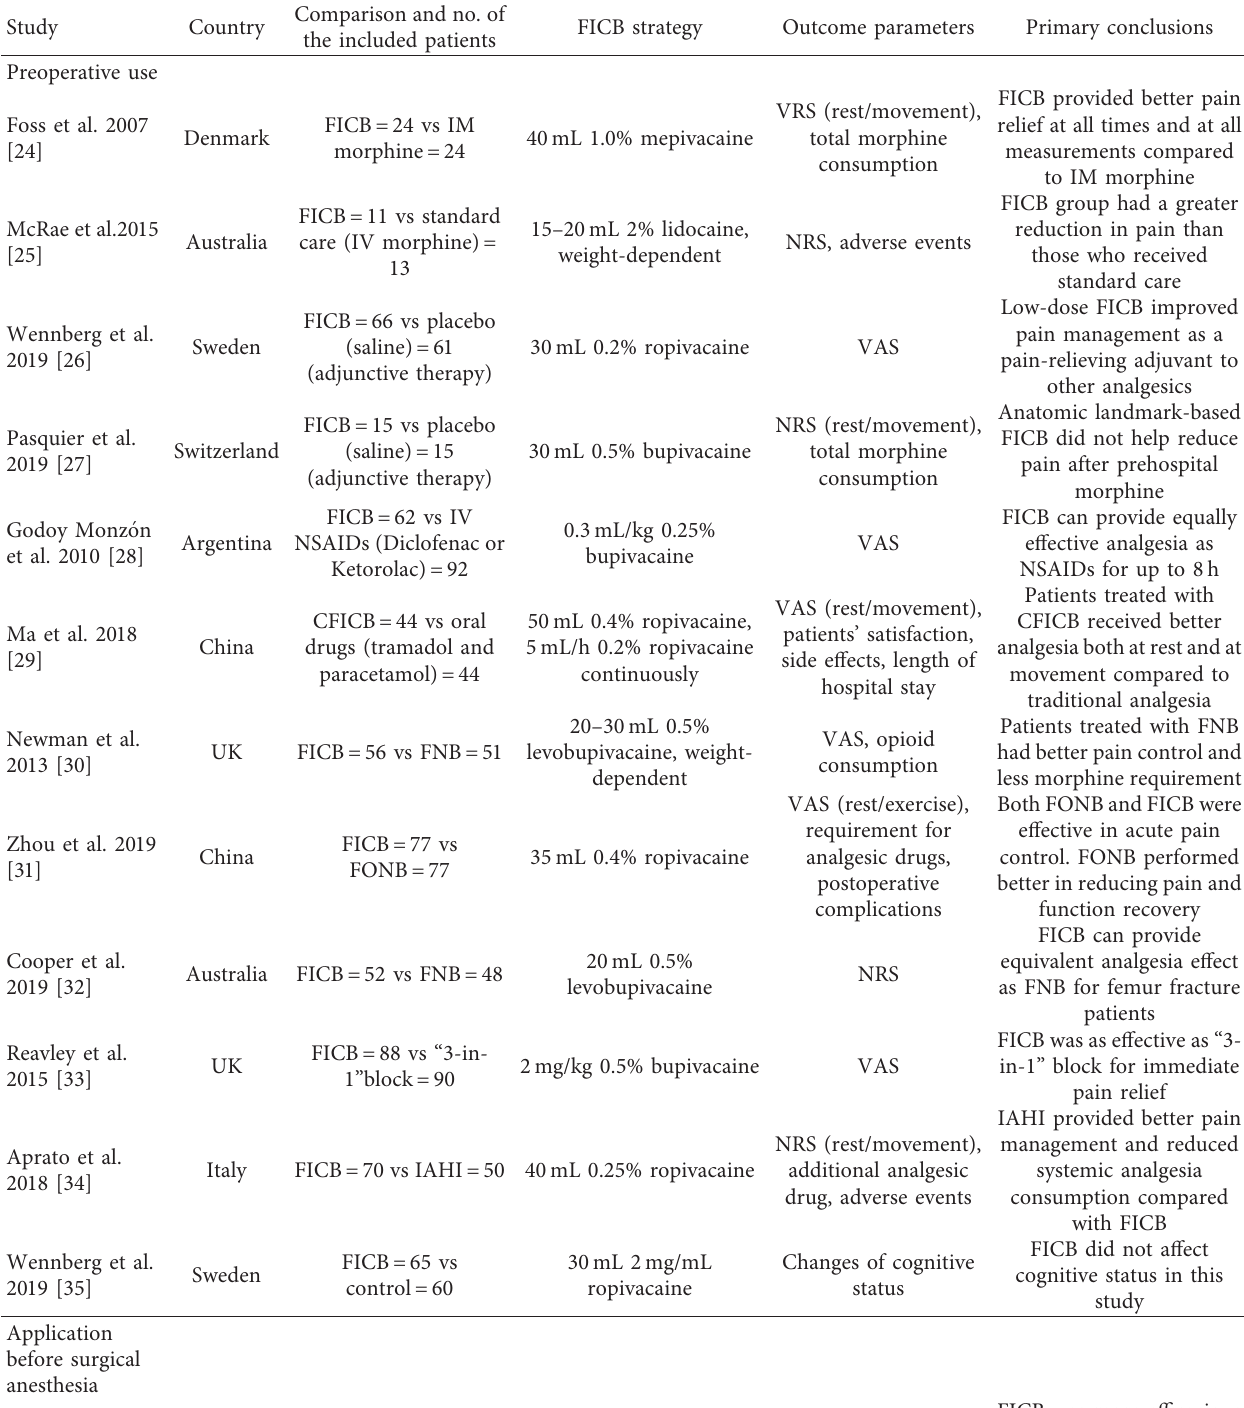
Table 3: RCTs evaluating FICB in pain management in geriatric patients with hip